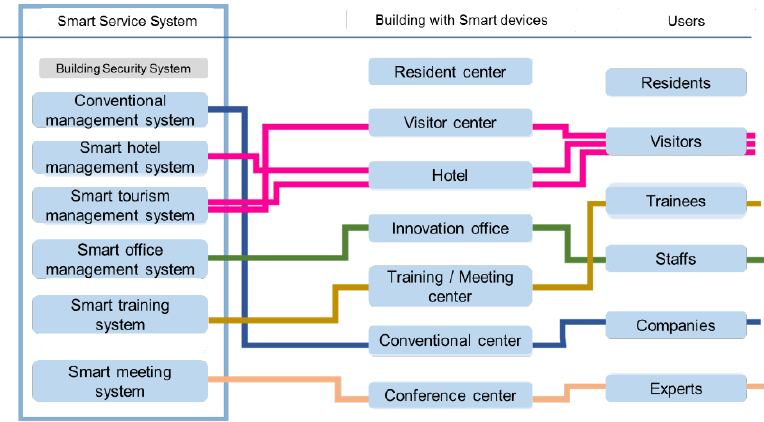
Figure 5. The other smart service system in the SVSMS. Table 3. Integrated personal information in building spaces with the SSS.